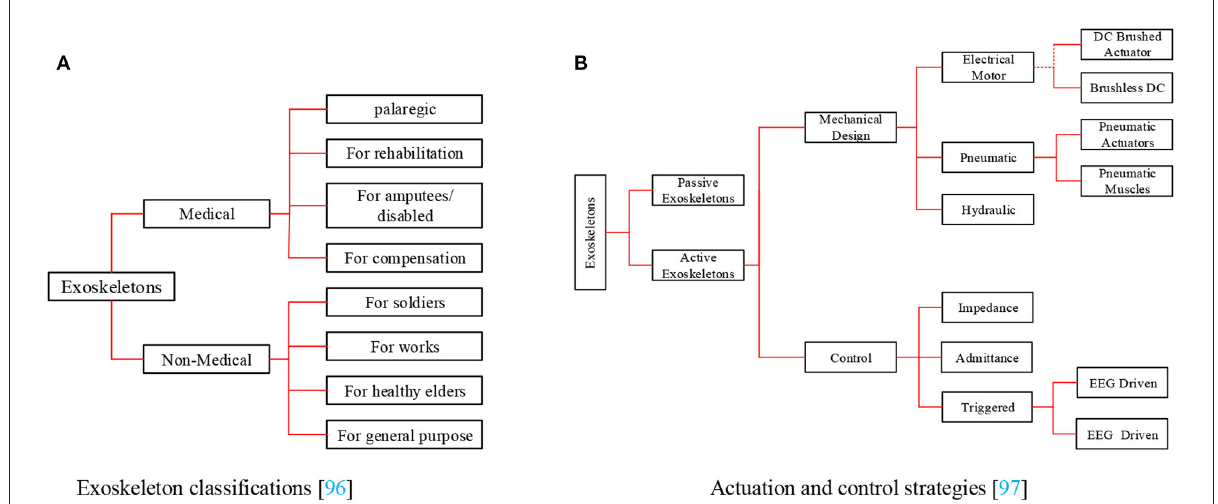
FIGURE4 Exoskeleton classifications and actuation approaches. (A) Exoskeleton classifications (Rupal et al., 2017). (B) Actuation and control strategies ( Frisoli, 2018).